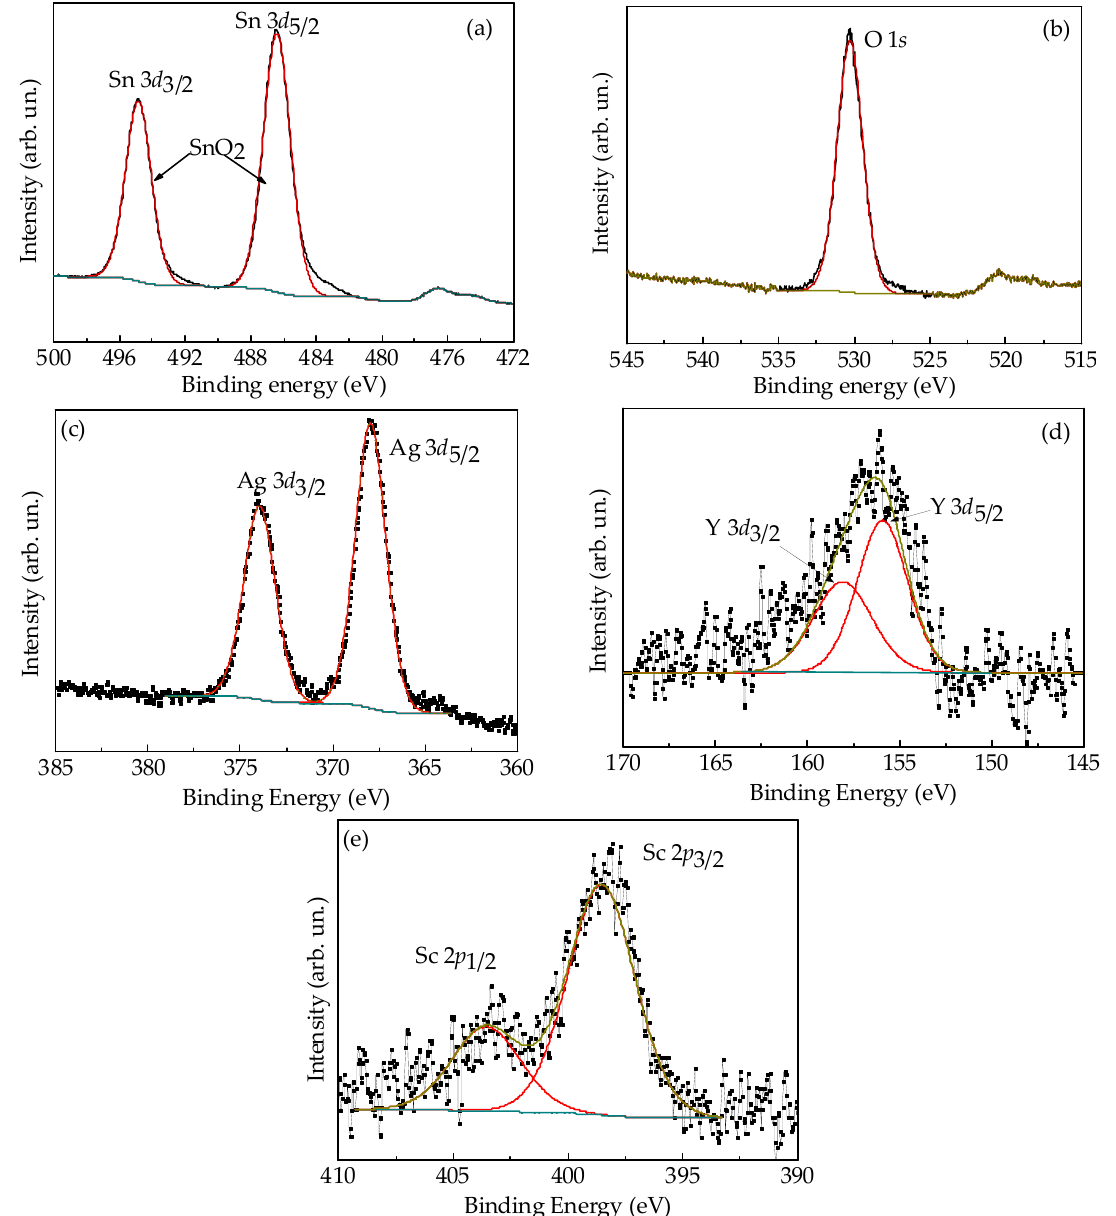
Figure 7. XPS spectra for ( a ) Sn 3 d , ( b ) O 1 s , ( c ) Ag 3 d , ( d ) Y 3 d , and ( e ) Sc 2 p .